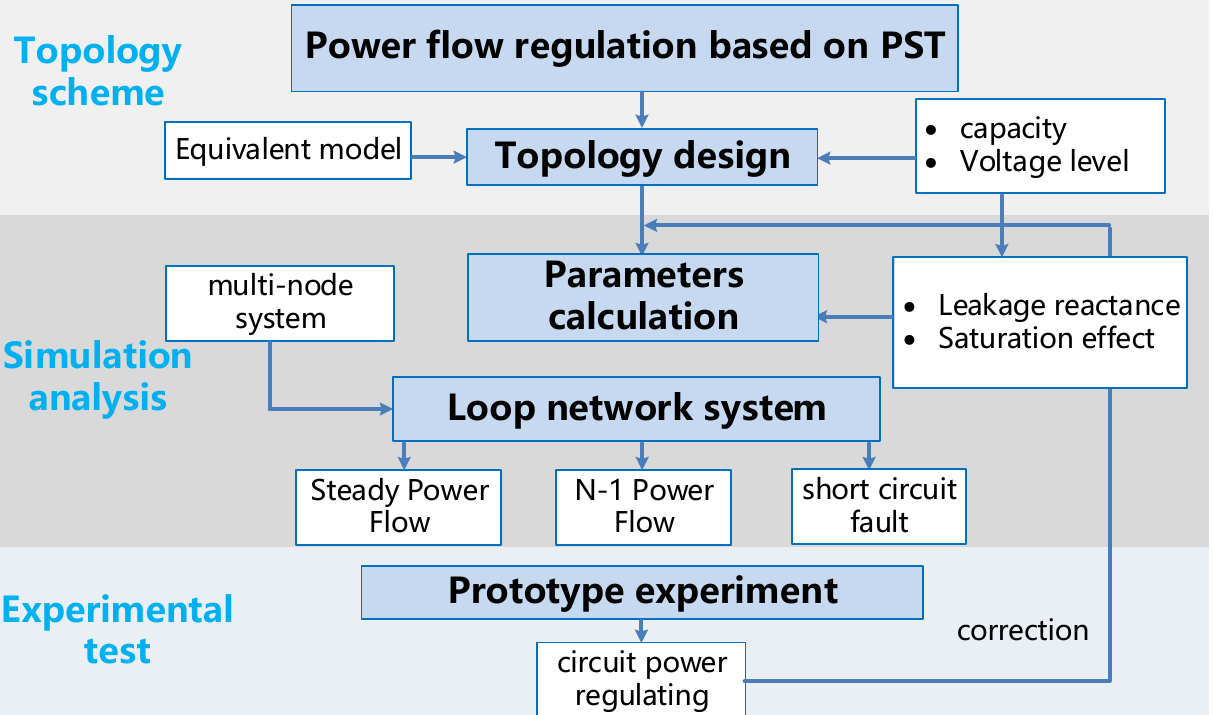
Figure 2. Workflow of the load flow optimization with PST.